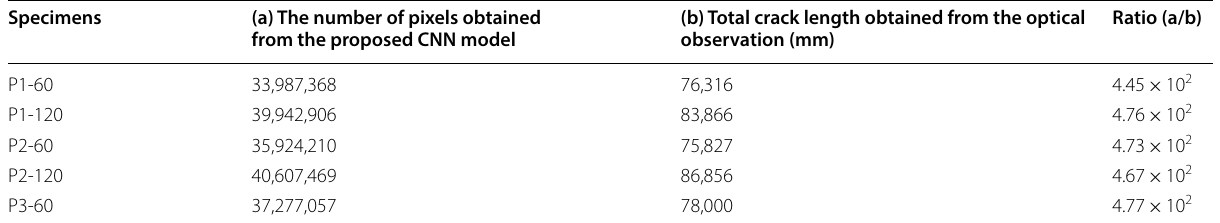
Table 4 The number of pixels recognized as cracks from the proposed CNN model and the total crack length obtained from optical